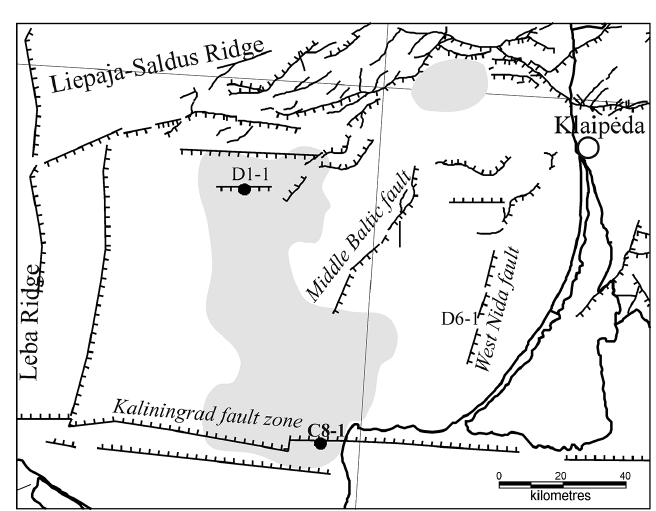
Fig. 11. Faults dissecting Palaeozoic sediments. Bold lines show faults (bergstrichs indicate down- thrusted flanks). Wells D1-1 and C8-1 are